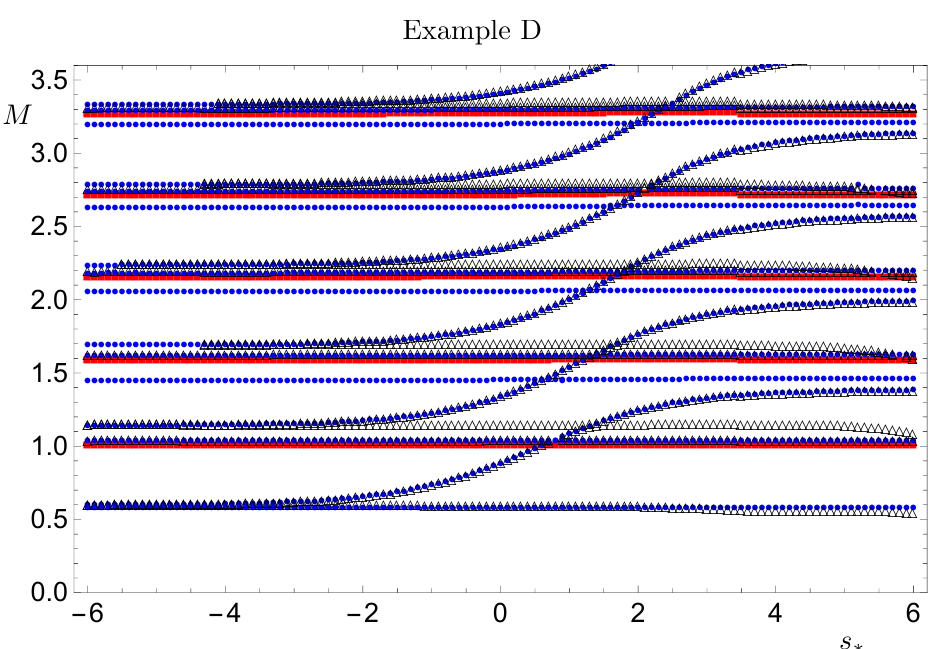
p Figure 5 . Masses M = (cid:0) q 2 of modes in the torus reduction of maximal D = 7 dimensional supergravity, as a function of the parameter s (cid:3) . All masses are expressed in units of the mass of the lightest tensor mode. The (red) squares represent the tensor modes, the (blue) circles are the scalar modes, computed with the complete, gauge-invariant variables, while the (black) triangles are the scalar modes computed by making use of the probe approximation. We notice that in the probe approximation, and for large negative values of s (cid:3) , two of the towers of scalar state become so close to degenerate that in our numerical study we could not resolve them. Conversely, for large positive values of s*, we notice what appears to be cuto(cid:11) artifacts in the case of the probe approximation. In the numerical calculations (cid:26) 1 = 0 : 001 and (cid:26) 2 =